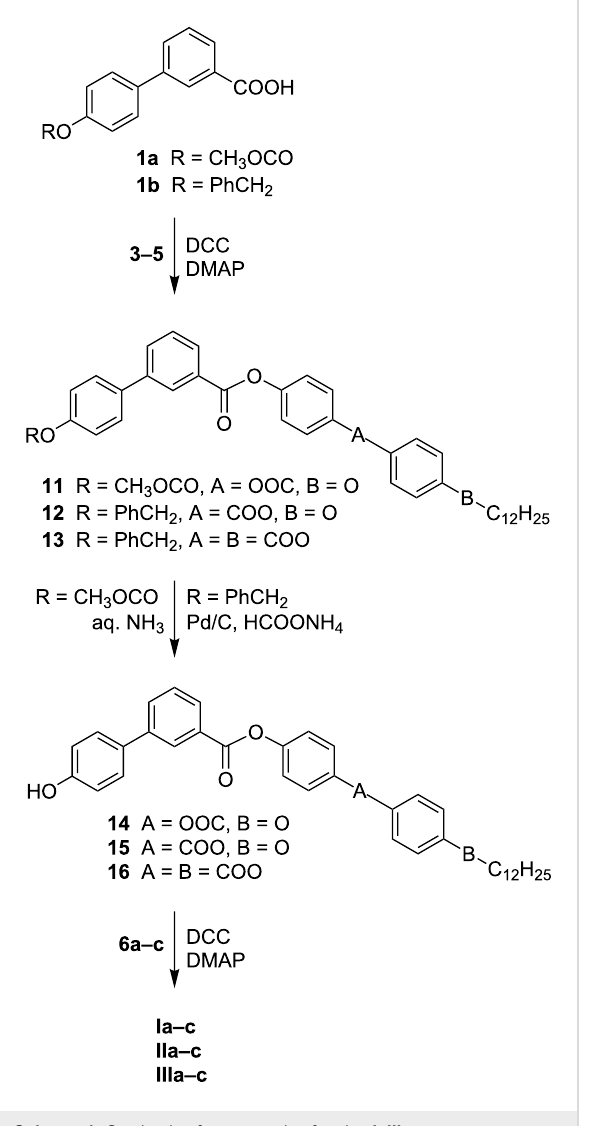
Scheme 1: Synthesis of compounds of series I – III .